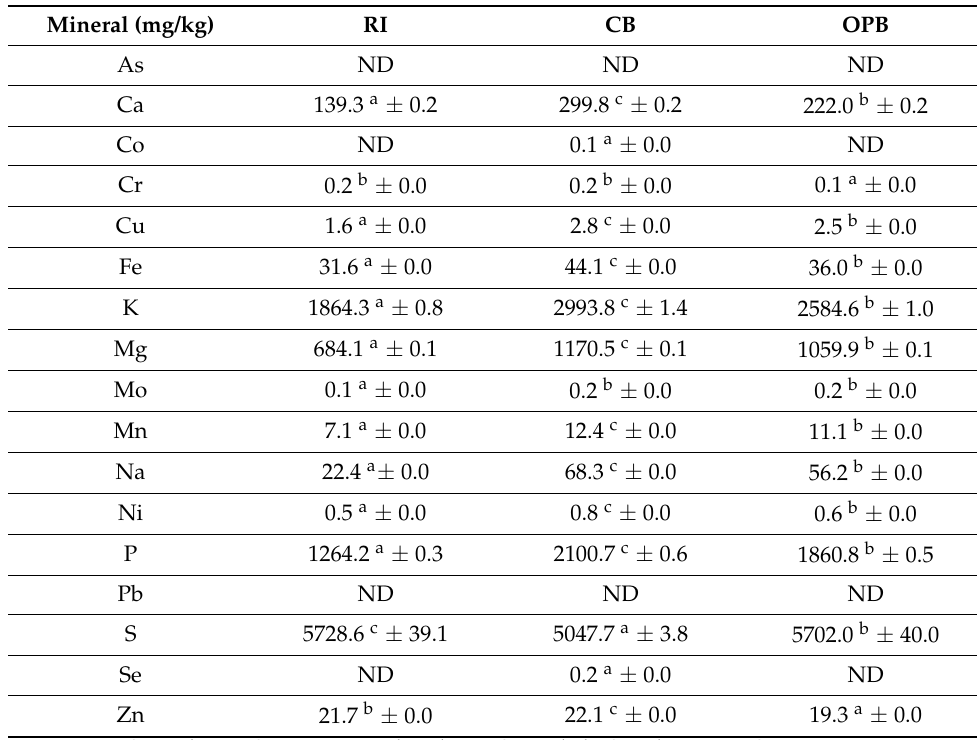
Table 2. Mineral compositions of umqombothi produced under optimum